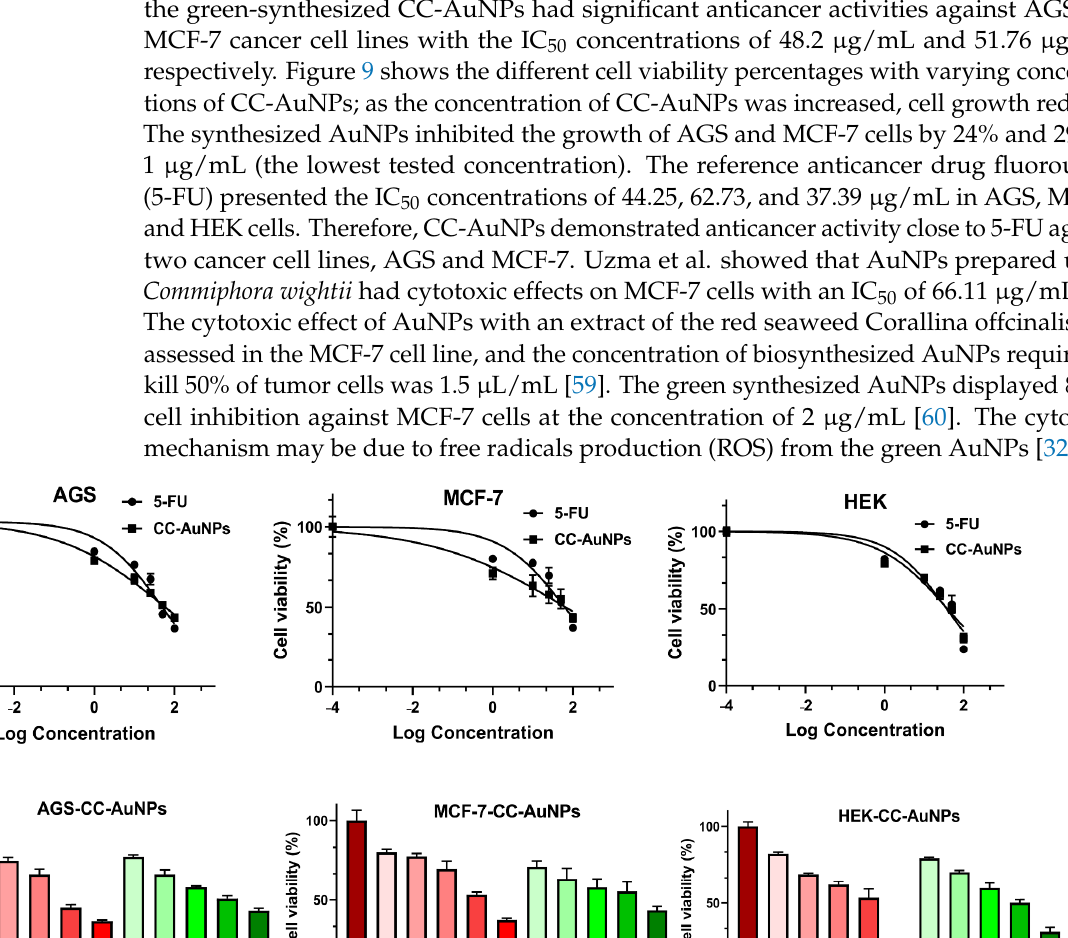
Table 3. The MIC value achieved from biosynthesized CC-AuNPs against fungi strains.